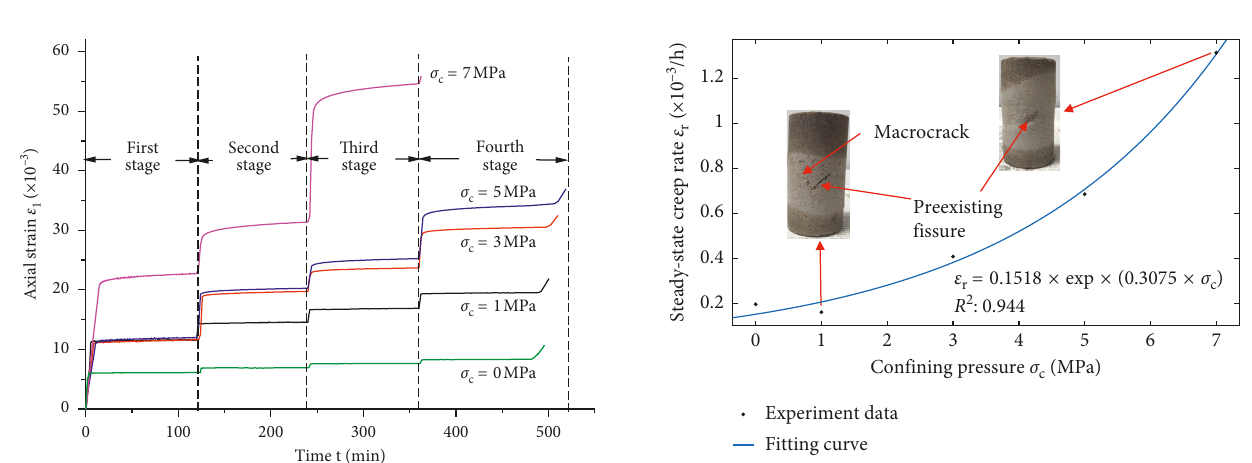
Figure 8: Strain-time curves obtained from triaxial multistage creep experiments for the shale-like material under different confining pressures (T � 20 °